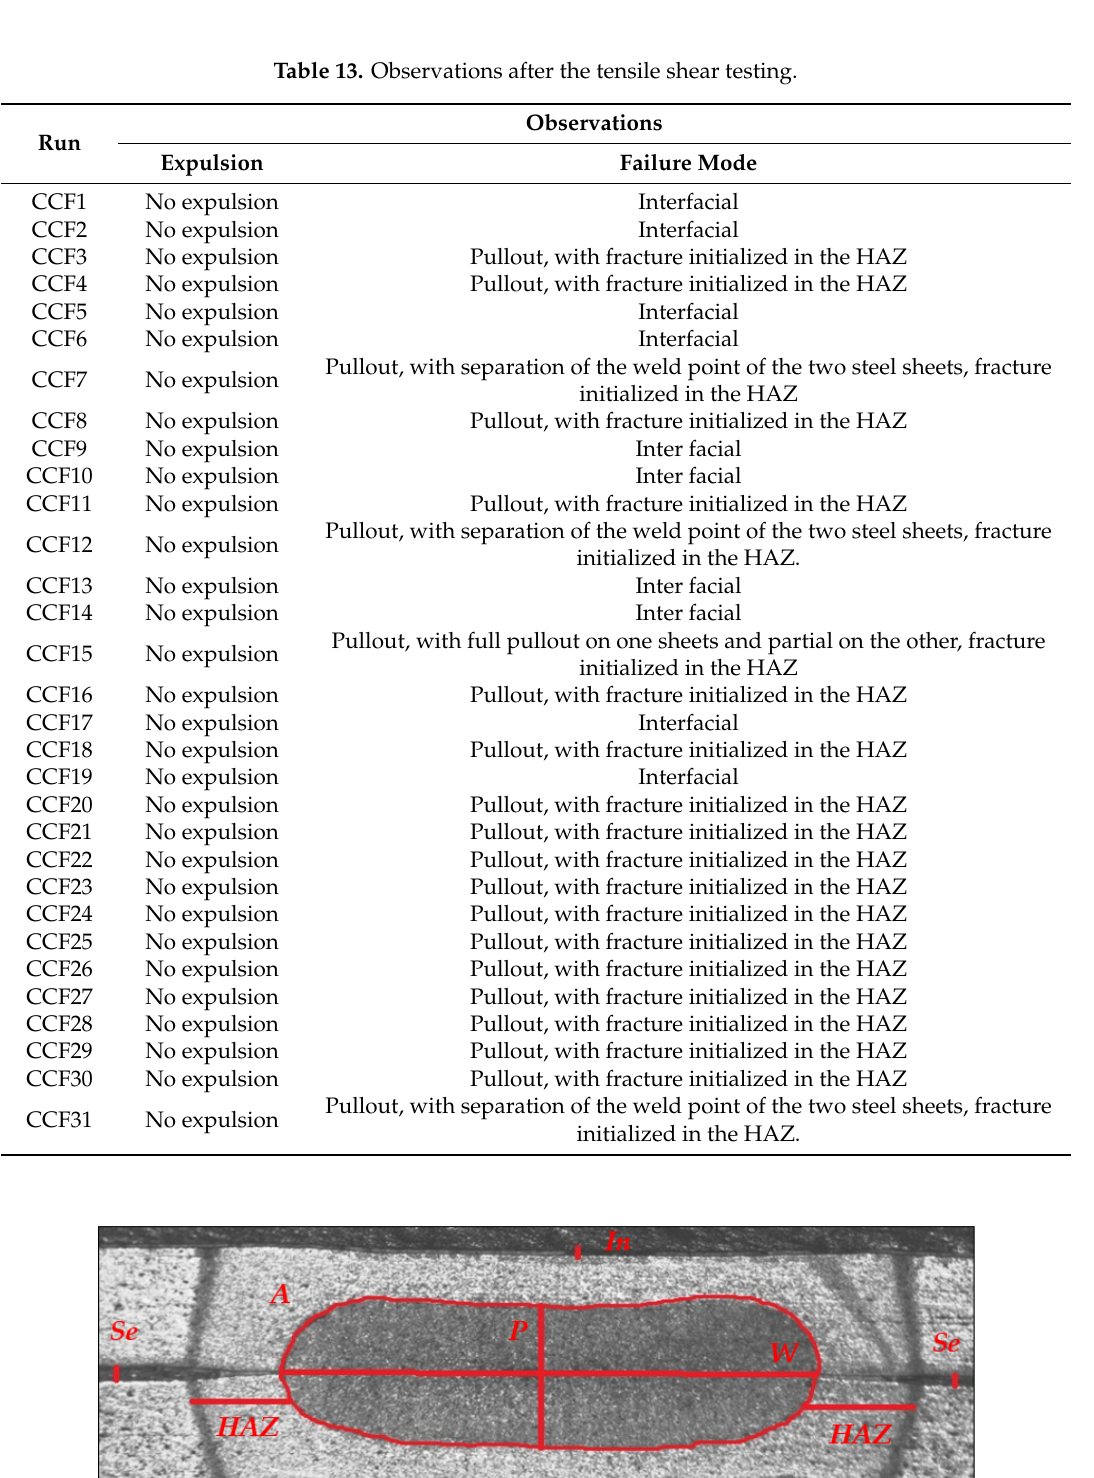
Table 14. Correlation structure among the responses. Responses Table 15. Results of the principal component analysis. Principal component analysis Eigenvalue